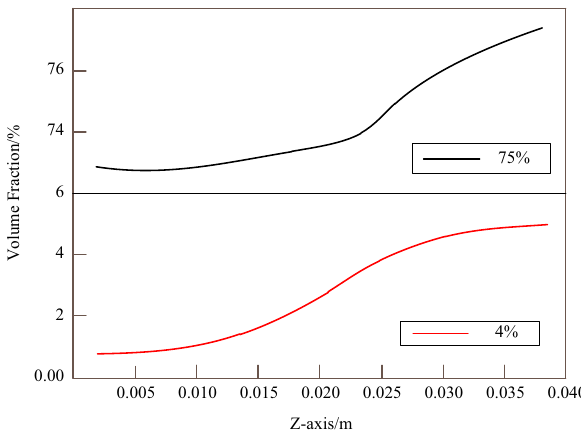
Figure 3: Variation of multicomponent combustible gas concentra - tion with Z - axis height of tank.